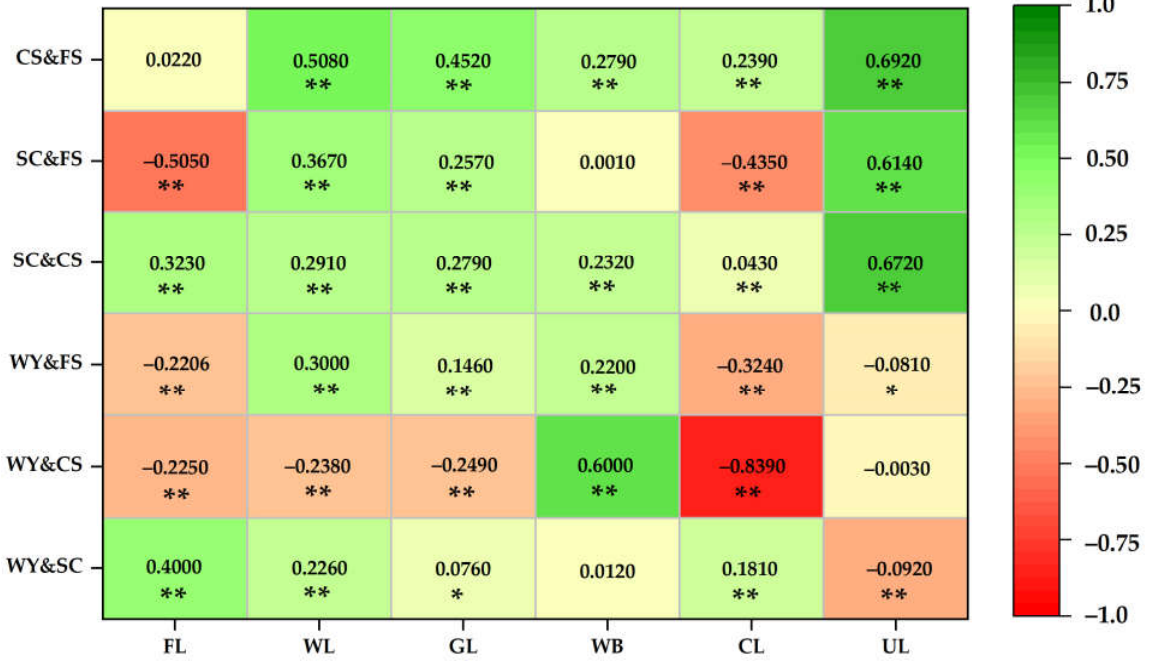
Figure 9. Correlation of ecosystem services among the land use types. Note: (1) ** at the 0.01 level (two-tailed), the correlation is significant; (2) * at the 0.05 level (two-tailed), the correlation is significant; (3) FL, WL, GL, WB, CL and UL represent farmland, woodland, grassland, water, construction land and unused land, respectively; (4) green indicates the synergy between ecosystem services (>0), that is, the ecosystem services in pairs are strengthened or weakened at the same time. Red indicates the trade-off relationship between ecosystem services (<0), that is, one ecosystem service function is strengthened/weakened, and the other ecosystem service function is weakened/strengthened.